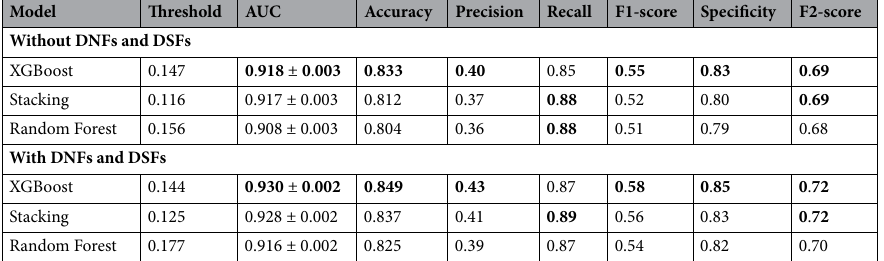
Table 1. Results based on three models with and without differential features. The result with the best performance in each metric using different classifiers are marked in bold